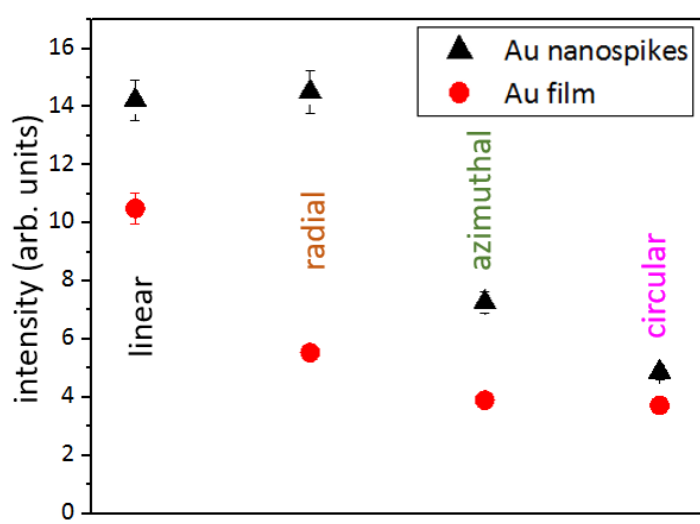
Figure 10. PL intensity measured at 625 nm for the unstructured Au film (red circles) and Au nanospikes (black triangles) for linear, radial, azimuthal and circular polarizations.